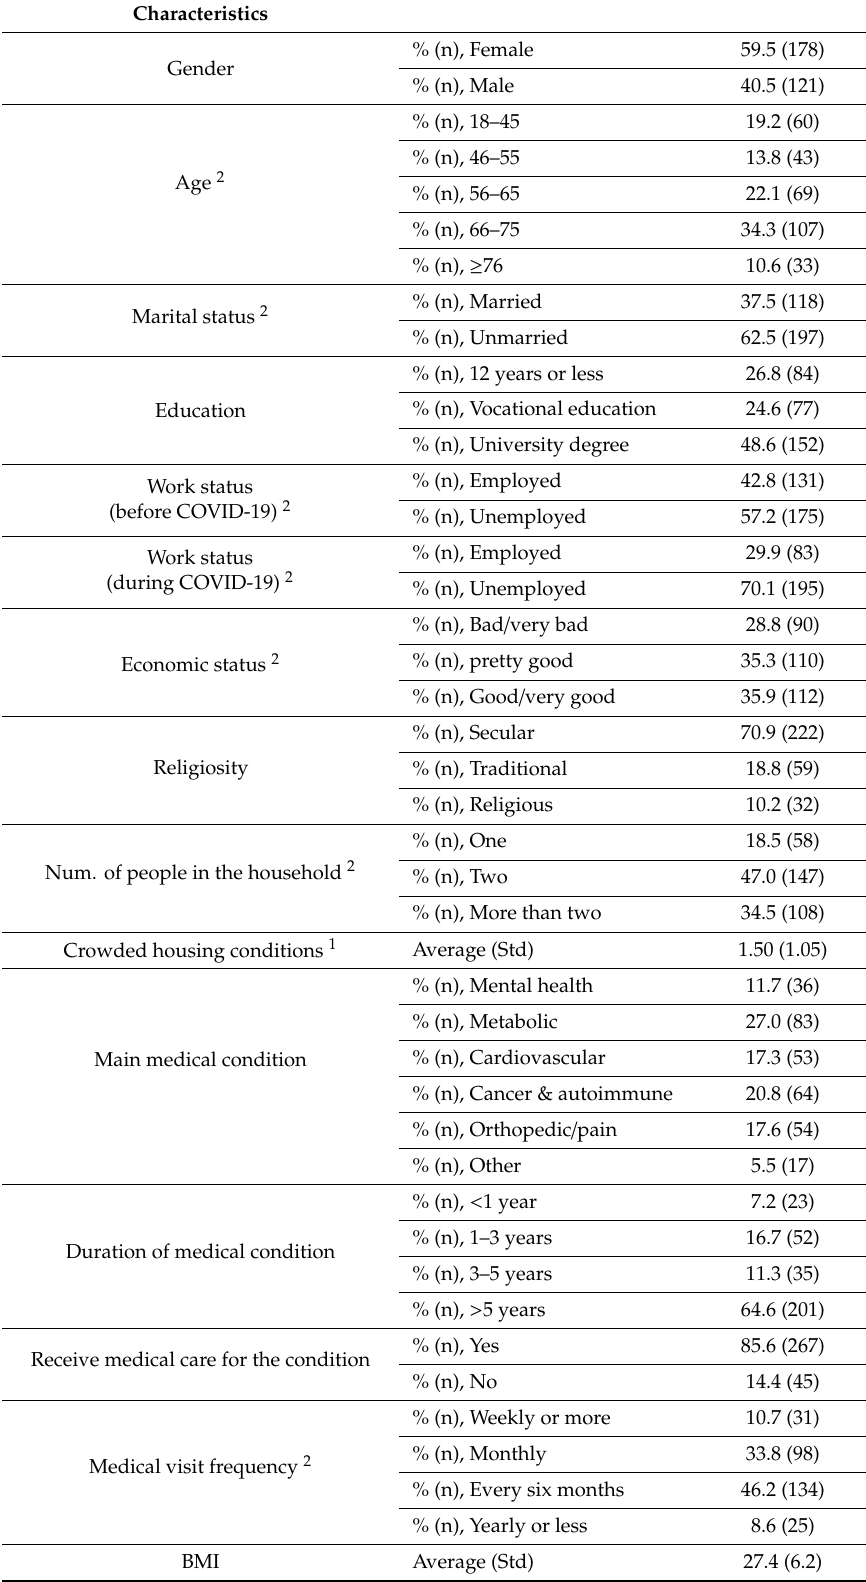
Table 1. Demographic and medical